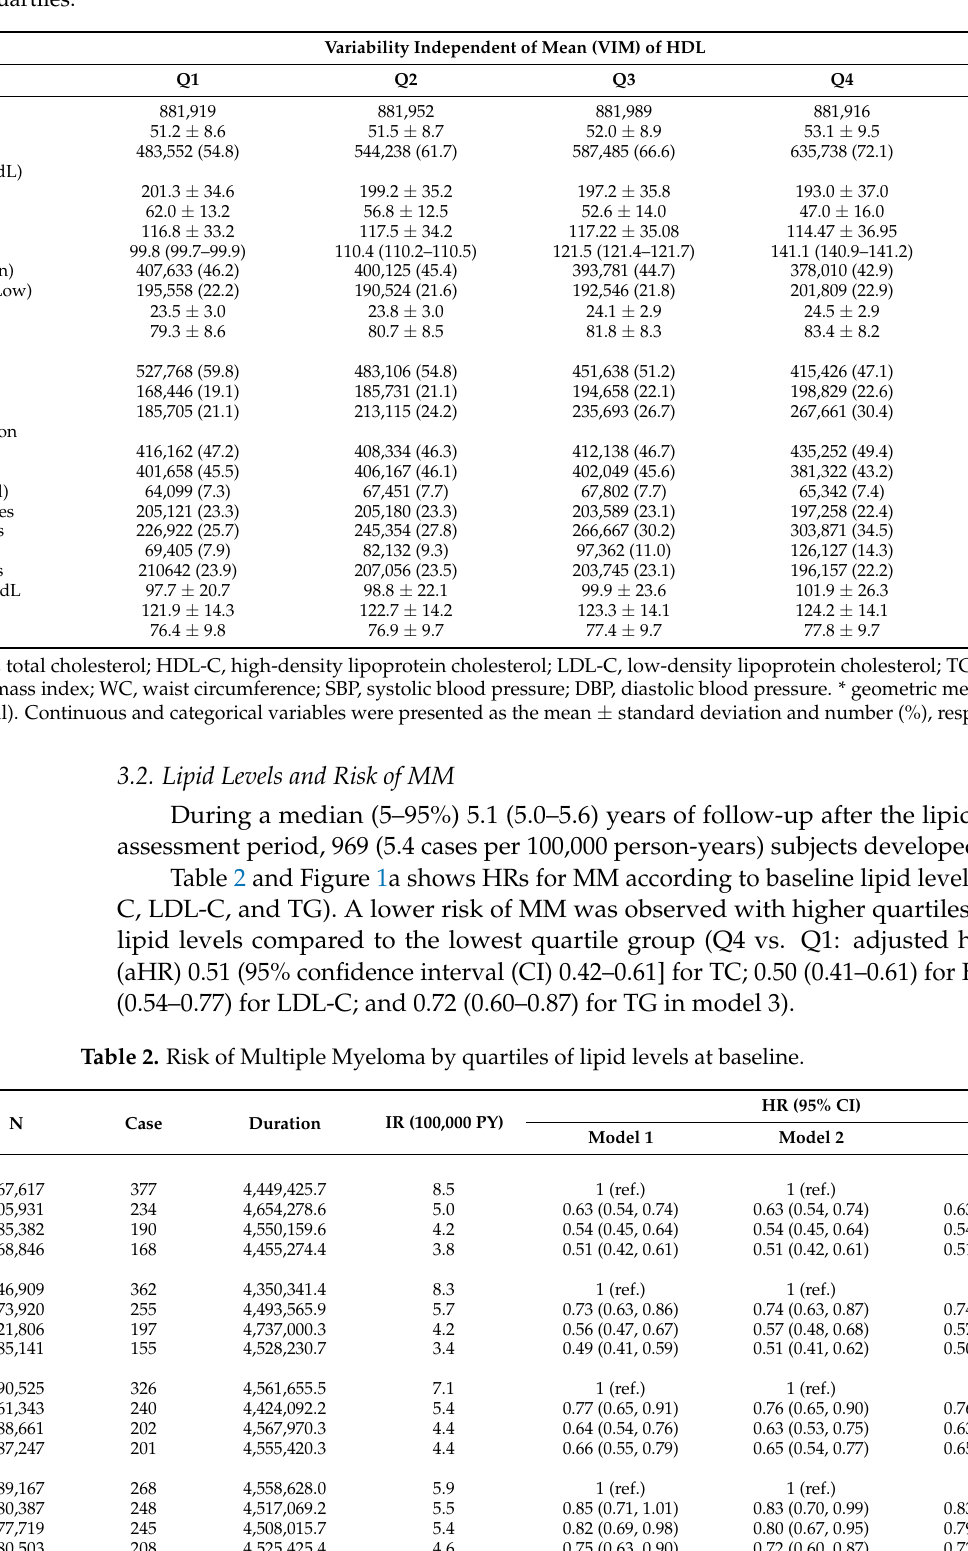
Table 1. Baseline characteristics of study population according to variability independent of the mean (VIM) of high density lipoprotein in quartiles.